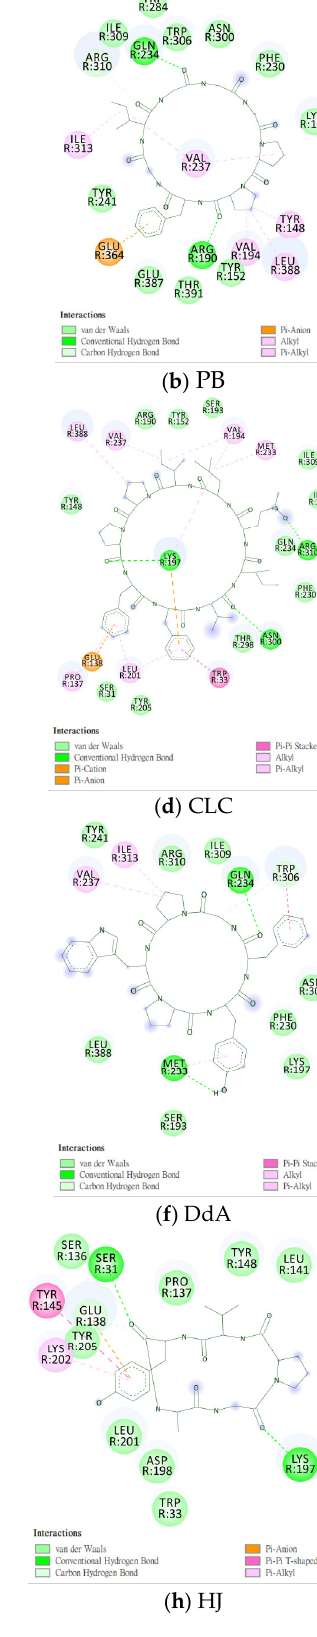
Figure 8. “Receptor–ligand interaction” of cyclopeptides from the three plants with GLP-1R. ( a